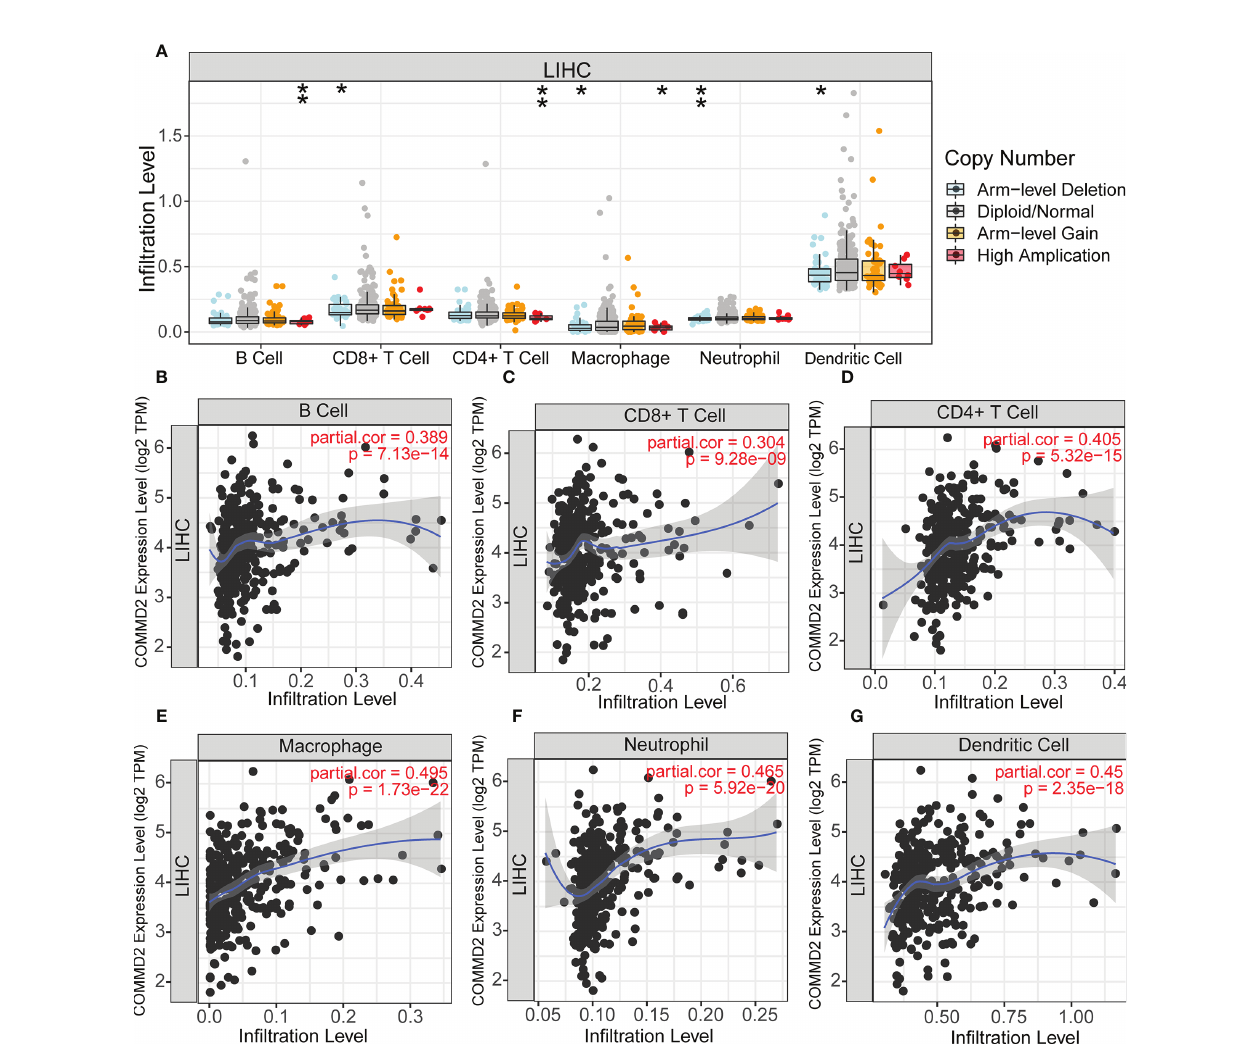
FIGURE 7 | Relationship Between COMMD2 and immune cell in fi ltration in LIHC. (A) Relationship Between COMMD2 copy number alterations and the in fi ltration level of six dominant immune cells in LIHC. (B – G) Correlations of COMMD2 with in fi ltrating B cells (B) , CD8+ T cells (C) , CD4+ T cells (D) , neutrophils (E) , macrophages (F) and dendritic cells (G) in LIHC. *p < 0.05; **p <